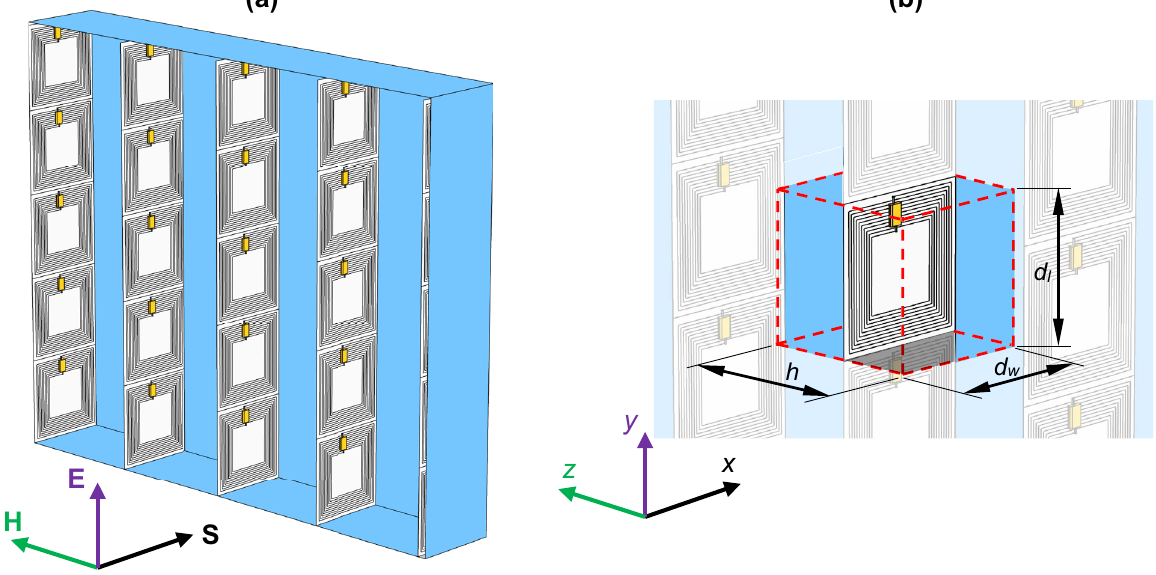
Figure 1. ( a ) Considered metamaterial composite consisting of an array of vertically stacked planar coils connected with lumped capacitors. Resonators are perpendicularly oriented with respect to magnetic field H of the incident plane wave S . ( b ) Unit cell of the metamaterial structure with a length d l , width d w and height h .